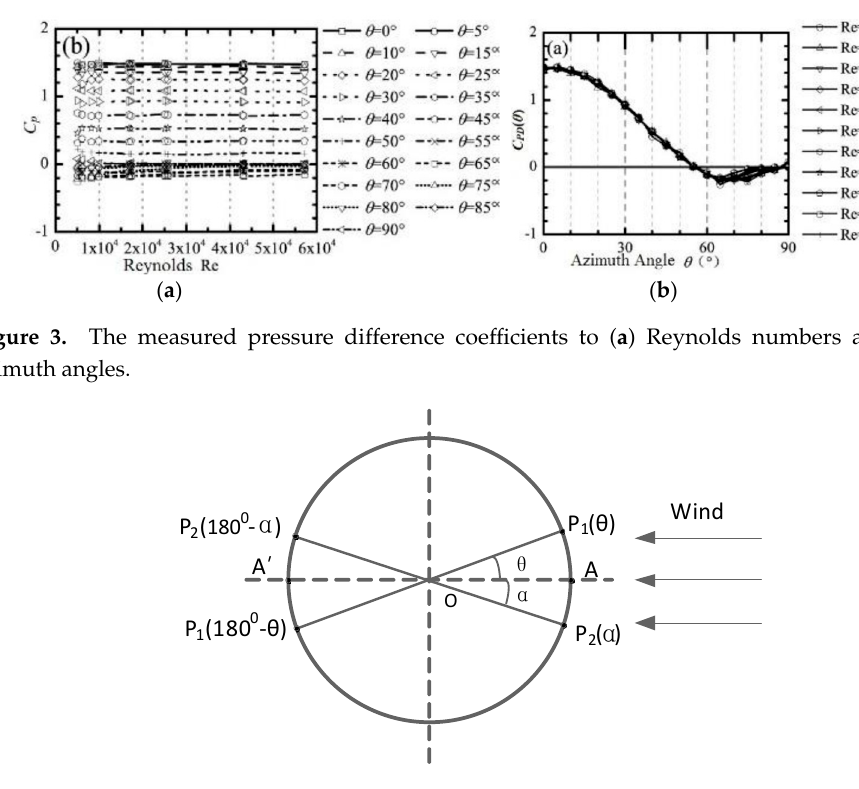
Figure 4. Distribution of P 1 and P 2